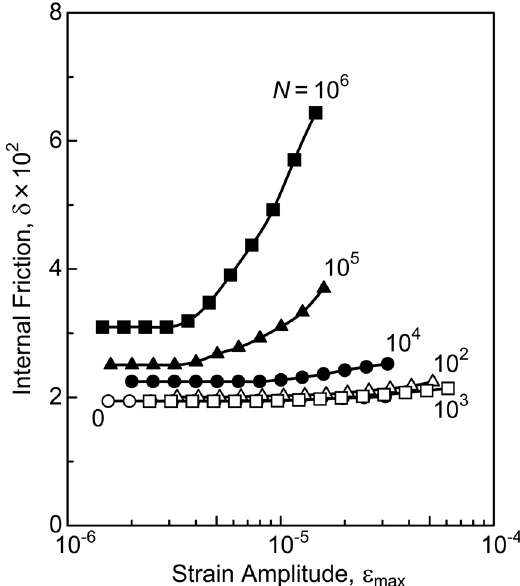
Figure 3. Internal friction δ plotted as a function of maximum strain amplitude ε in CFRP laminates subjected to fatigue cycling of N max = 10 2 -10 6 and undeformed ( N = 0) sample